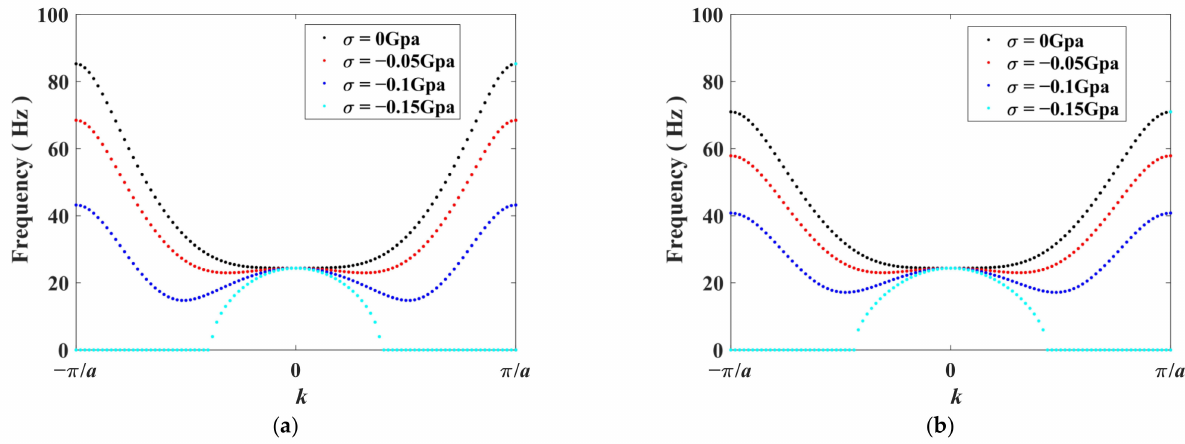
Figure 8. The first band structure with different axial compressive stress: ( a ) Euler beam; ( b ) Timoshenko